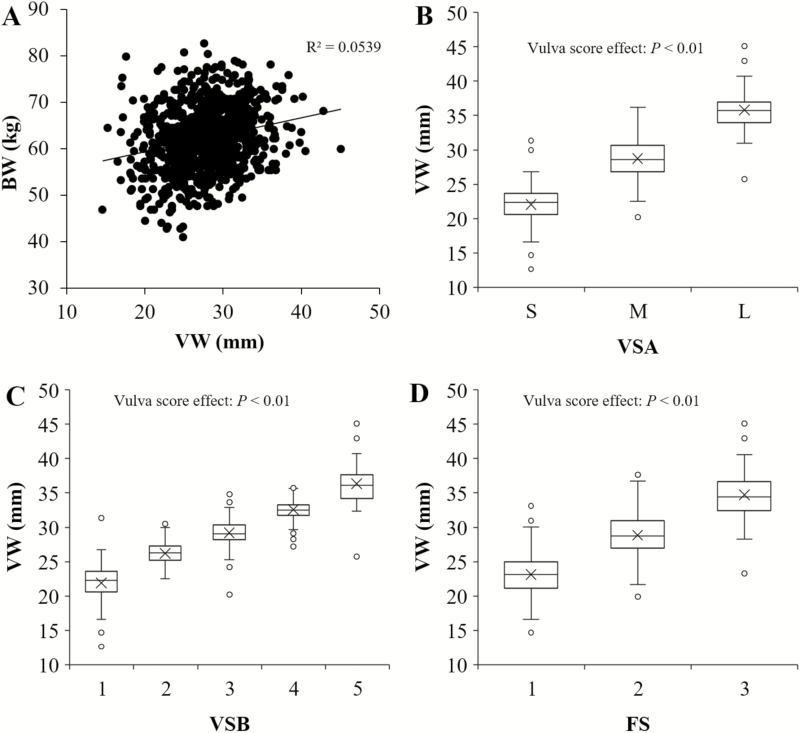
Relationship of vulva width (VW) with body weight (BW) and effectiveness of different vulva scoring methods to accurately partition gilts. (A) BW and VW were assessed at approximately 15 wk of age. A weak positive correlation exists between the 2 traits, with an R2 value of 0.05 (P < 0.01). (B–D) Box and whisker plots of distribution for VW measurements at 15 wk of age based on Vulva Score Method A (VSA; B), Vulva Score Method B (VSB; C), and Farm Score (FS; D). Each method, while variable, was effective in partitioning gilts into separate groups based on vulva size. Points shown beyond the whiskers represent outliers for each score within the scoring method. Whiskers denote the minimum and maximum value for each score while top and bottom boundaries represent the upper and lower quartiles, respectively, with the middle line indicating the median for each score. The X near the median line signifies the mean vulva width measurement for each category. Statistical significance exists for each vulva score mean across methods (P < 0.01).